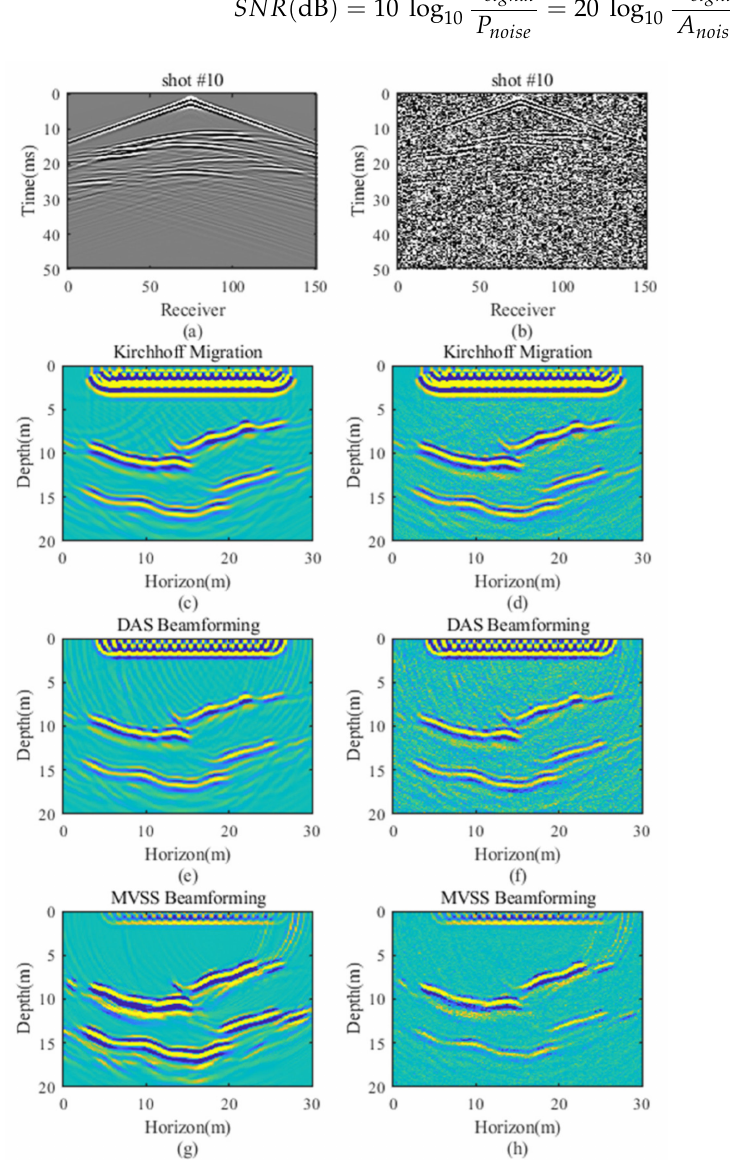
Figure 22. Imaging result using the clear signal ( a ) and noisy signal ( b ). ( c ) Kirchhoff migration imaging result using the clear signal. ( d ) DAS beamforming result using the clear signal. ( e ) MVSS beamforming result using the clear signal. ( f ) Kirchhoff migration imaging result using the noisy signal. ( g ) DAS beamforming result using the noisy signal. ( h ) MVSS beamforming result using the noisy